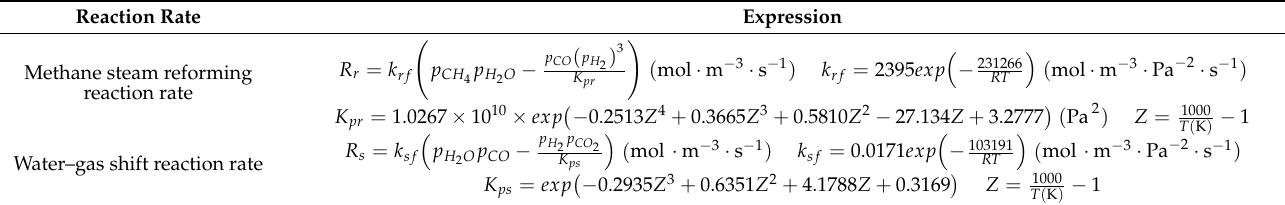
Table 1. Control equation for reaction rates